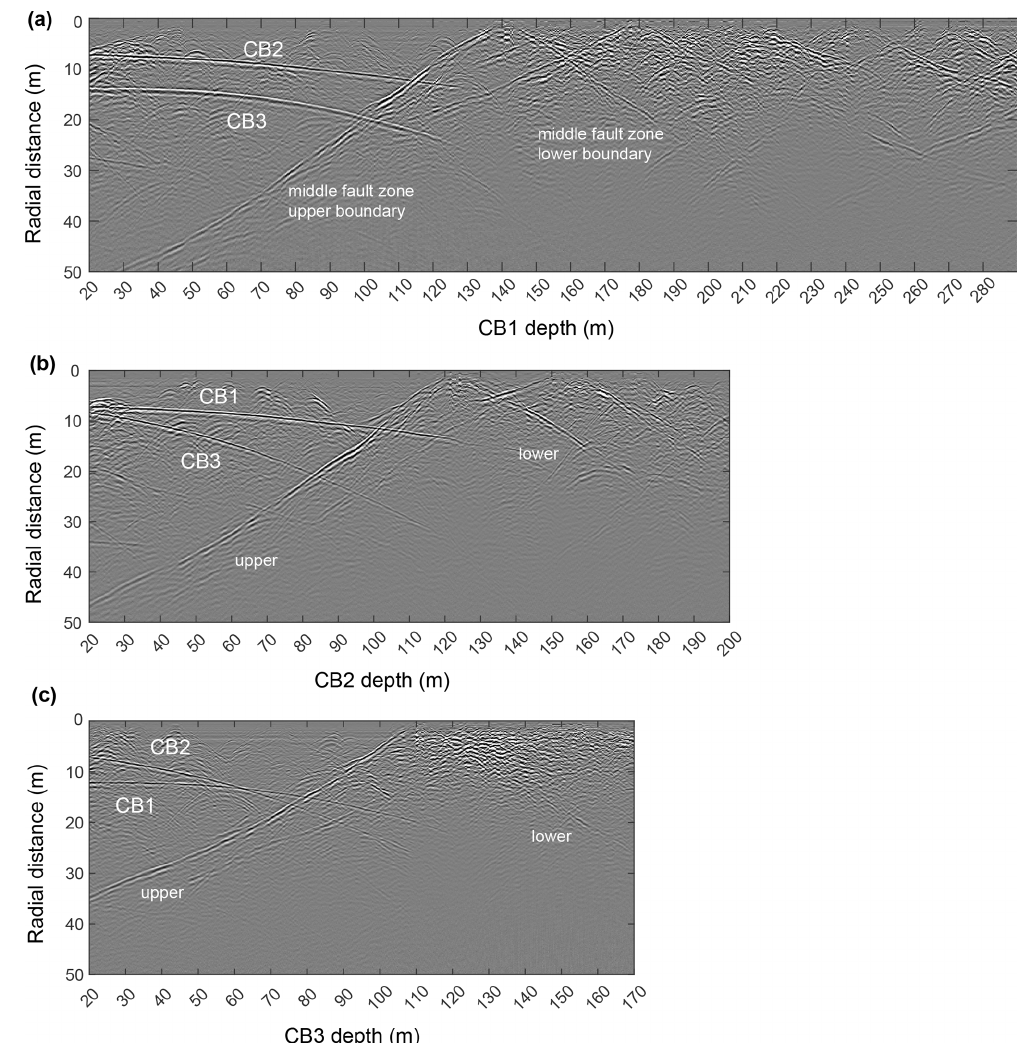
Figure 9. Single-hole GPR reflection profiles (100MHz) along (a) CB1, (b) CB2 and (c) CB3. From each borehole, the nearby boreholes are identified (and labeled) as prominent reflectors. The middle unit of the first major fault zone is clearly dominant in the figure. The fractured rock below this fault zone is characterized by higher reflectivity. Above the fault zone, some parabolic reflectors are seen that are likely attributed to borehole-perpendicular